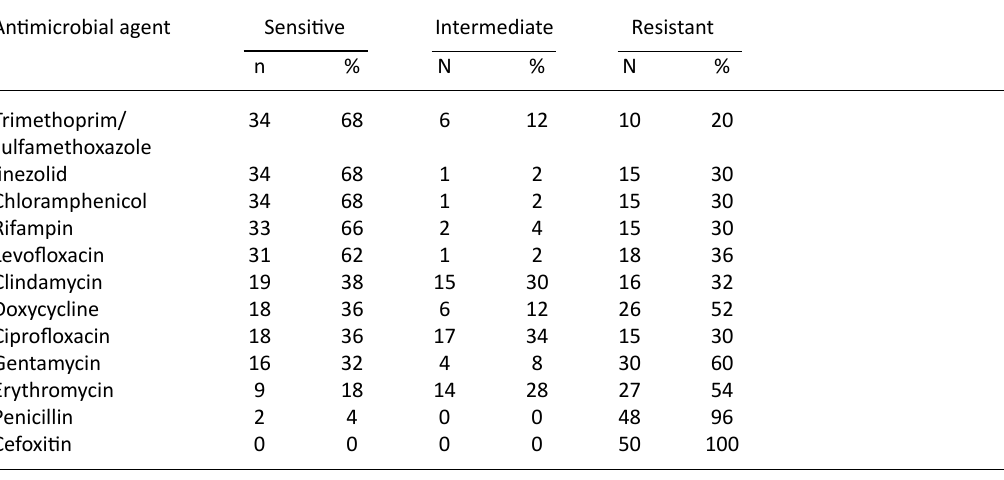
Table 1. Frequencies (n) and percentages (%) for antimicrobial susceptibility of MRSA arranged from highest to lowest sensitivity Antimicrobial agent Sensitive Intermediate Resistant